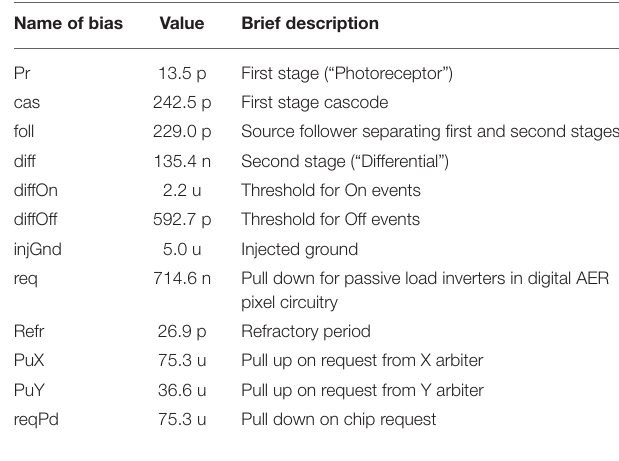
TABLE 1 | Bias values of the used DVS